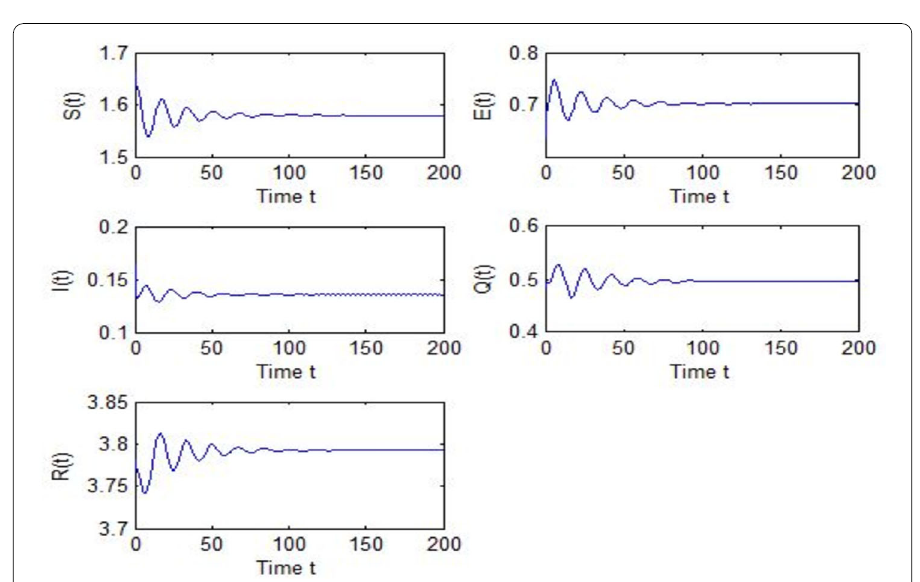
Figure 3 Evolutions of S , E , I , Q , R for τ 2 = 5.1264 < τ 20 along with time